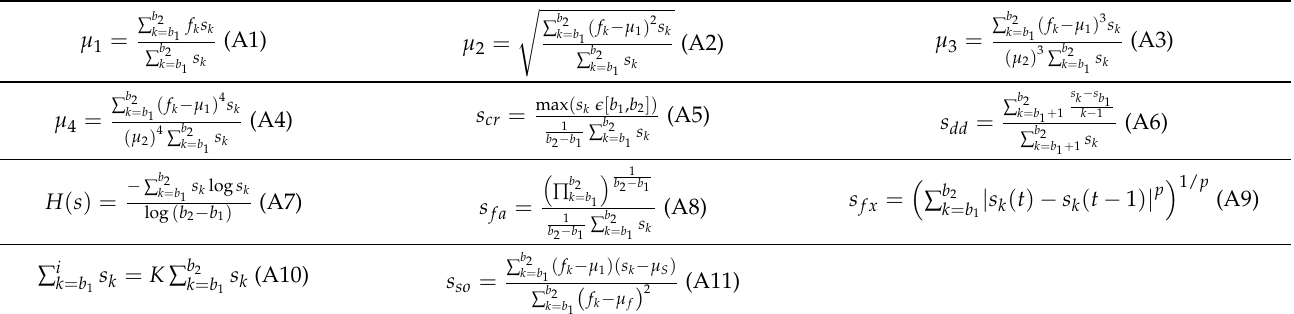
Table A1. Audio-based features used to characterize VF; see text for the names of the parameters and their qualitative